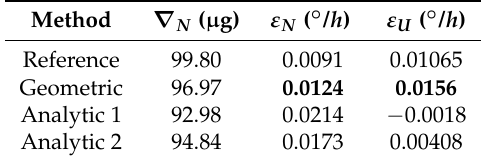
Figure 5. The bias estimation curve of the upward gyro by latitude of different LD method. Table 2. The biases estimation by different LD methods.